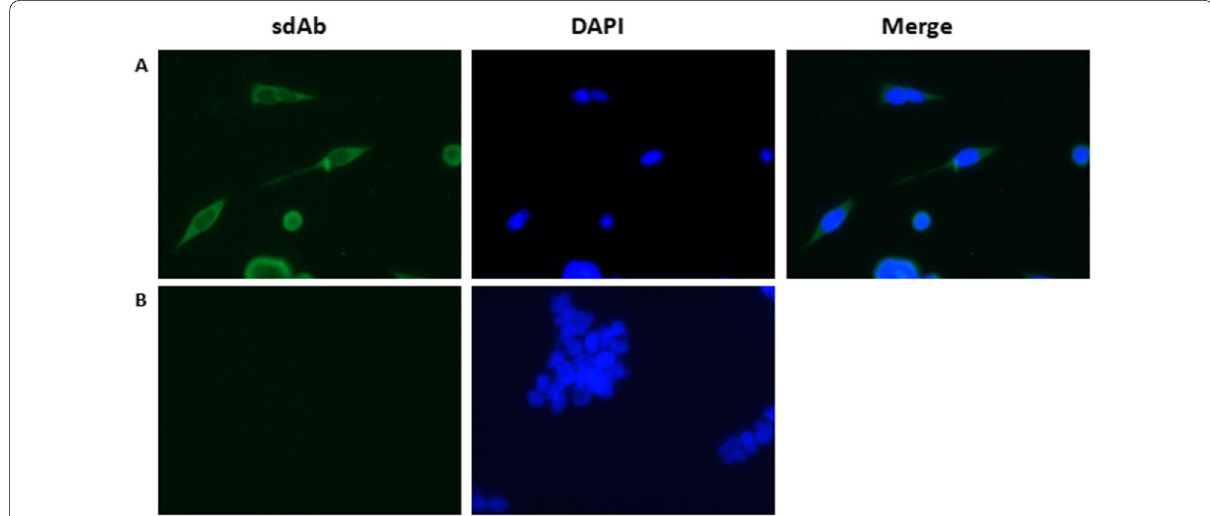
Fig. 11 Immunofluorescence assay. Adenovirus-infected HEK293A cells were incubated with sdAb 5 antibody and visualized with CoraLite ® 488-conjugated 6*His His-Tag mouse monoclonal antibody. HEK293A cells uninfected with adenovirus rAd26 were used as a negative control. The cell nuclei were stained with DAPI. The fluorescent signal and images were obtained using confocal microscopy. The merged images showed the localization of adenovirus rAd26 in HEK293A cells (Fig. 11 A ), but there was no fluorescent signal in the uninfected HEK293A cells